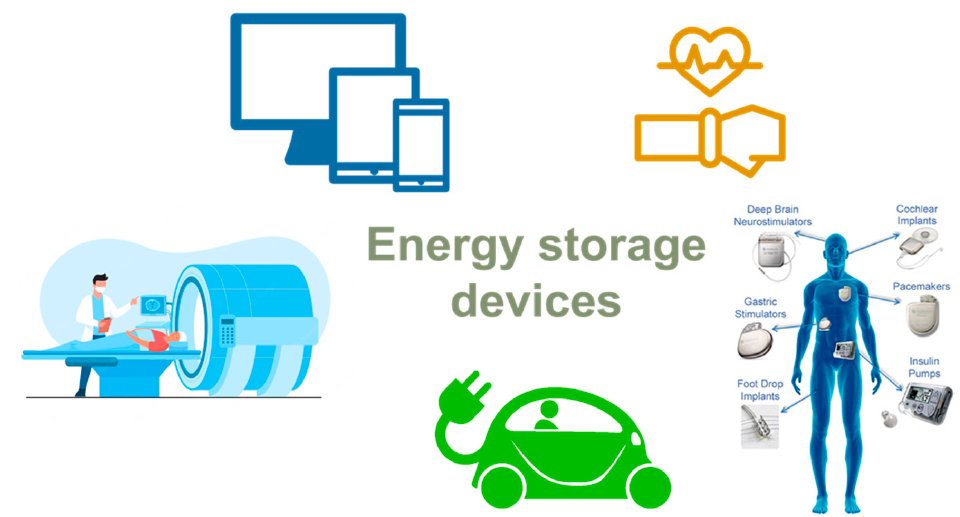
Figure 1. Examples of the emerging applications for which the development of efficient energy storage devices are crucial.